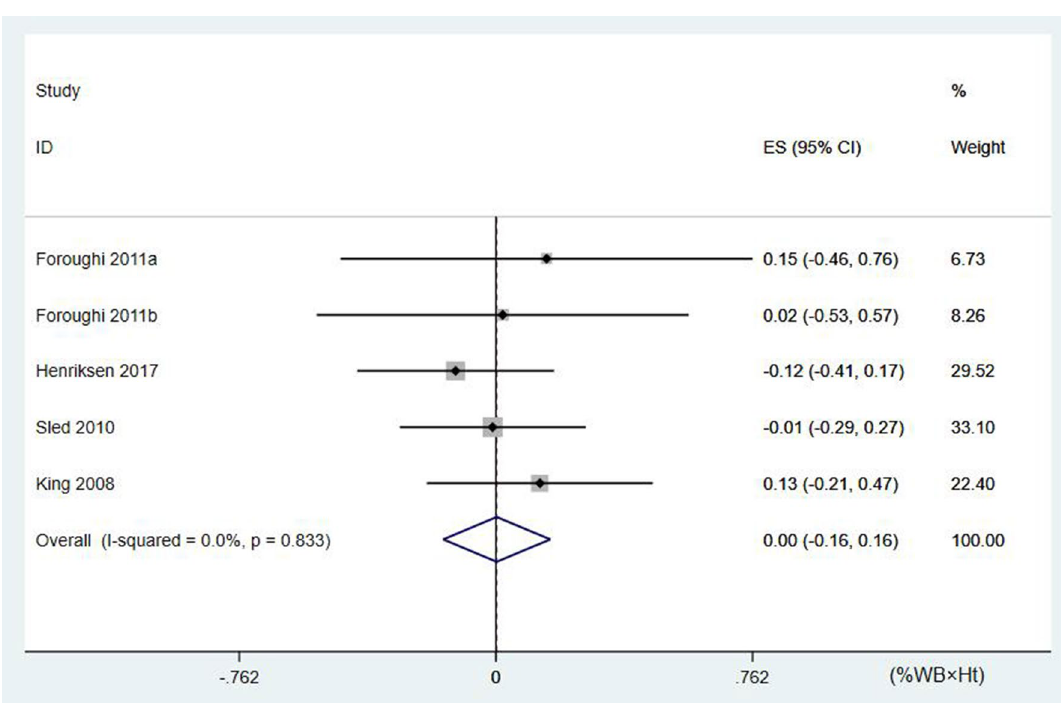
Figure 3. The forest plot of the effect size for studies assessing the effect of resistance exercise on the knee adduction moment (KAM) of patients with knee osteoarthritis. The summary effect estimates for individual studies are indicated by the gray rectangles, with the size of the rectangles proportional to the study weight. The lines represent 95% CI. The overall summary effect estimate and 95% CI are indicated by the diamond